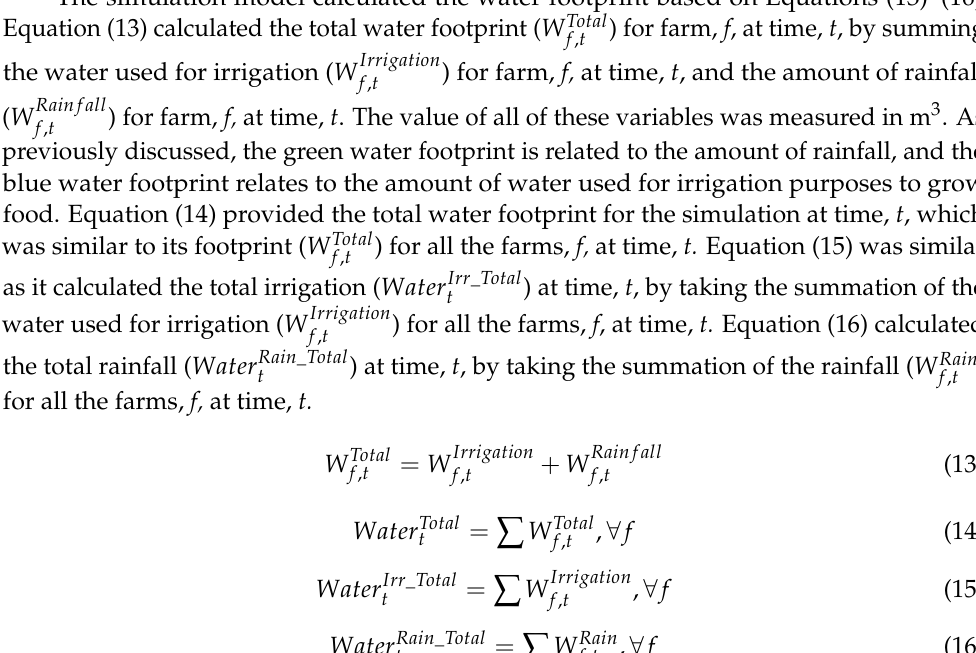
Figure 14. Weekly irrigation (m 3 ) at each urban farm for a one-year time period.